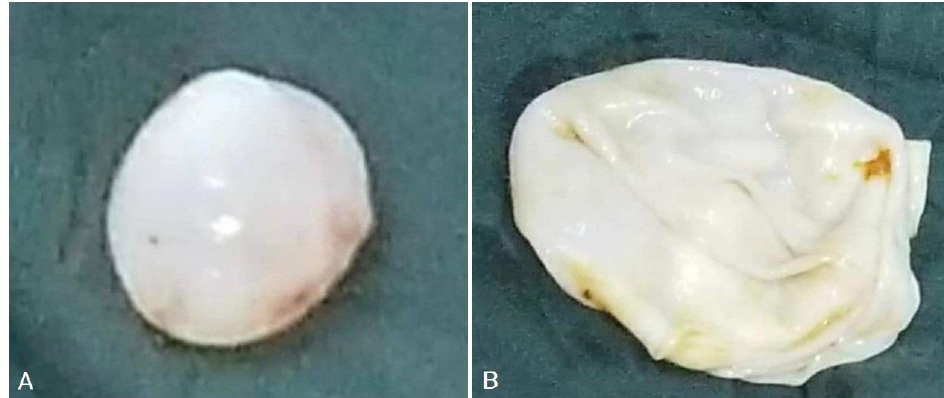
Figure 2. Images of gross hydatid cysts from outside ( A ), and inside ( B ) of two different